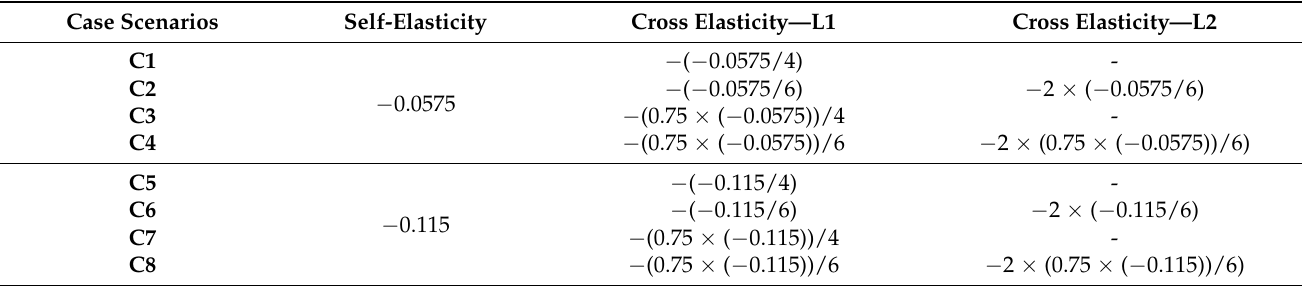
Table 12. Finalized